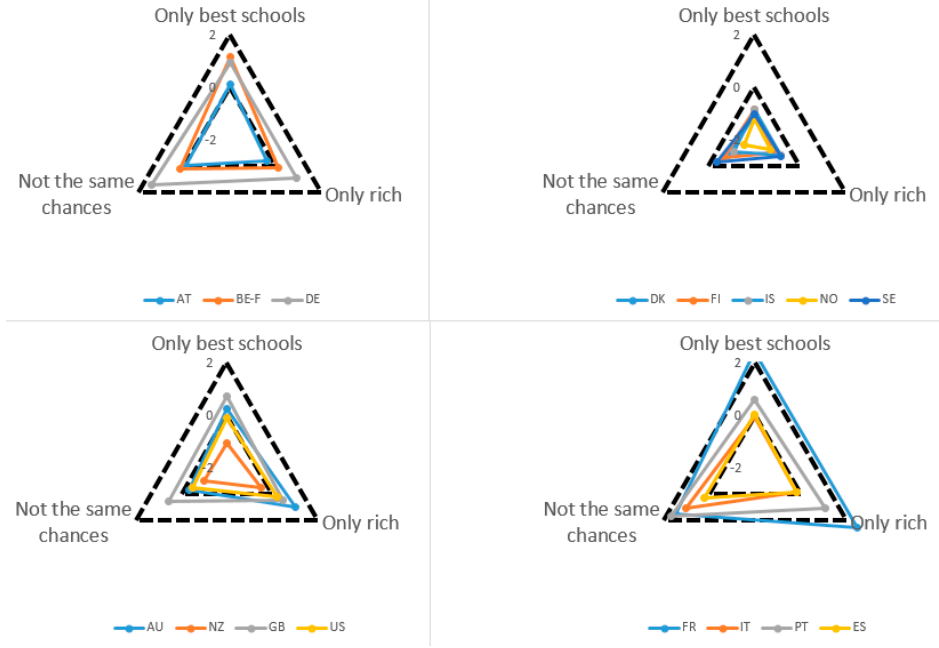
Figure 5. Standardized polygons, representing the shares agreeing that access to university is not fair.